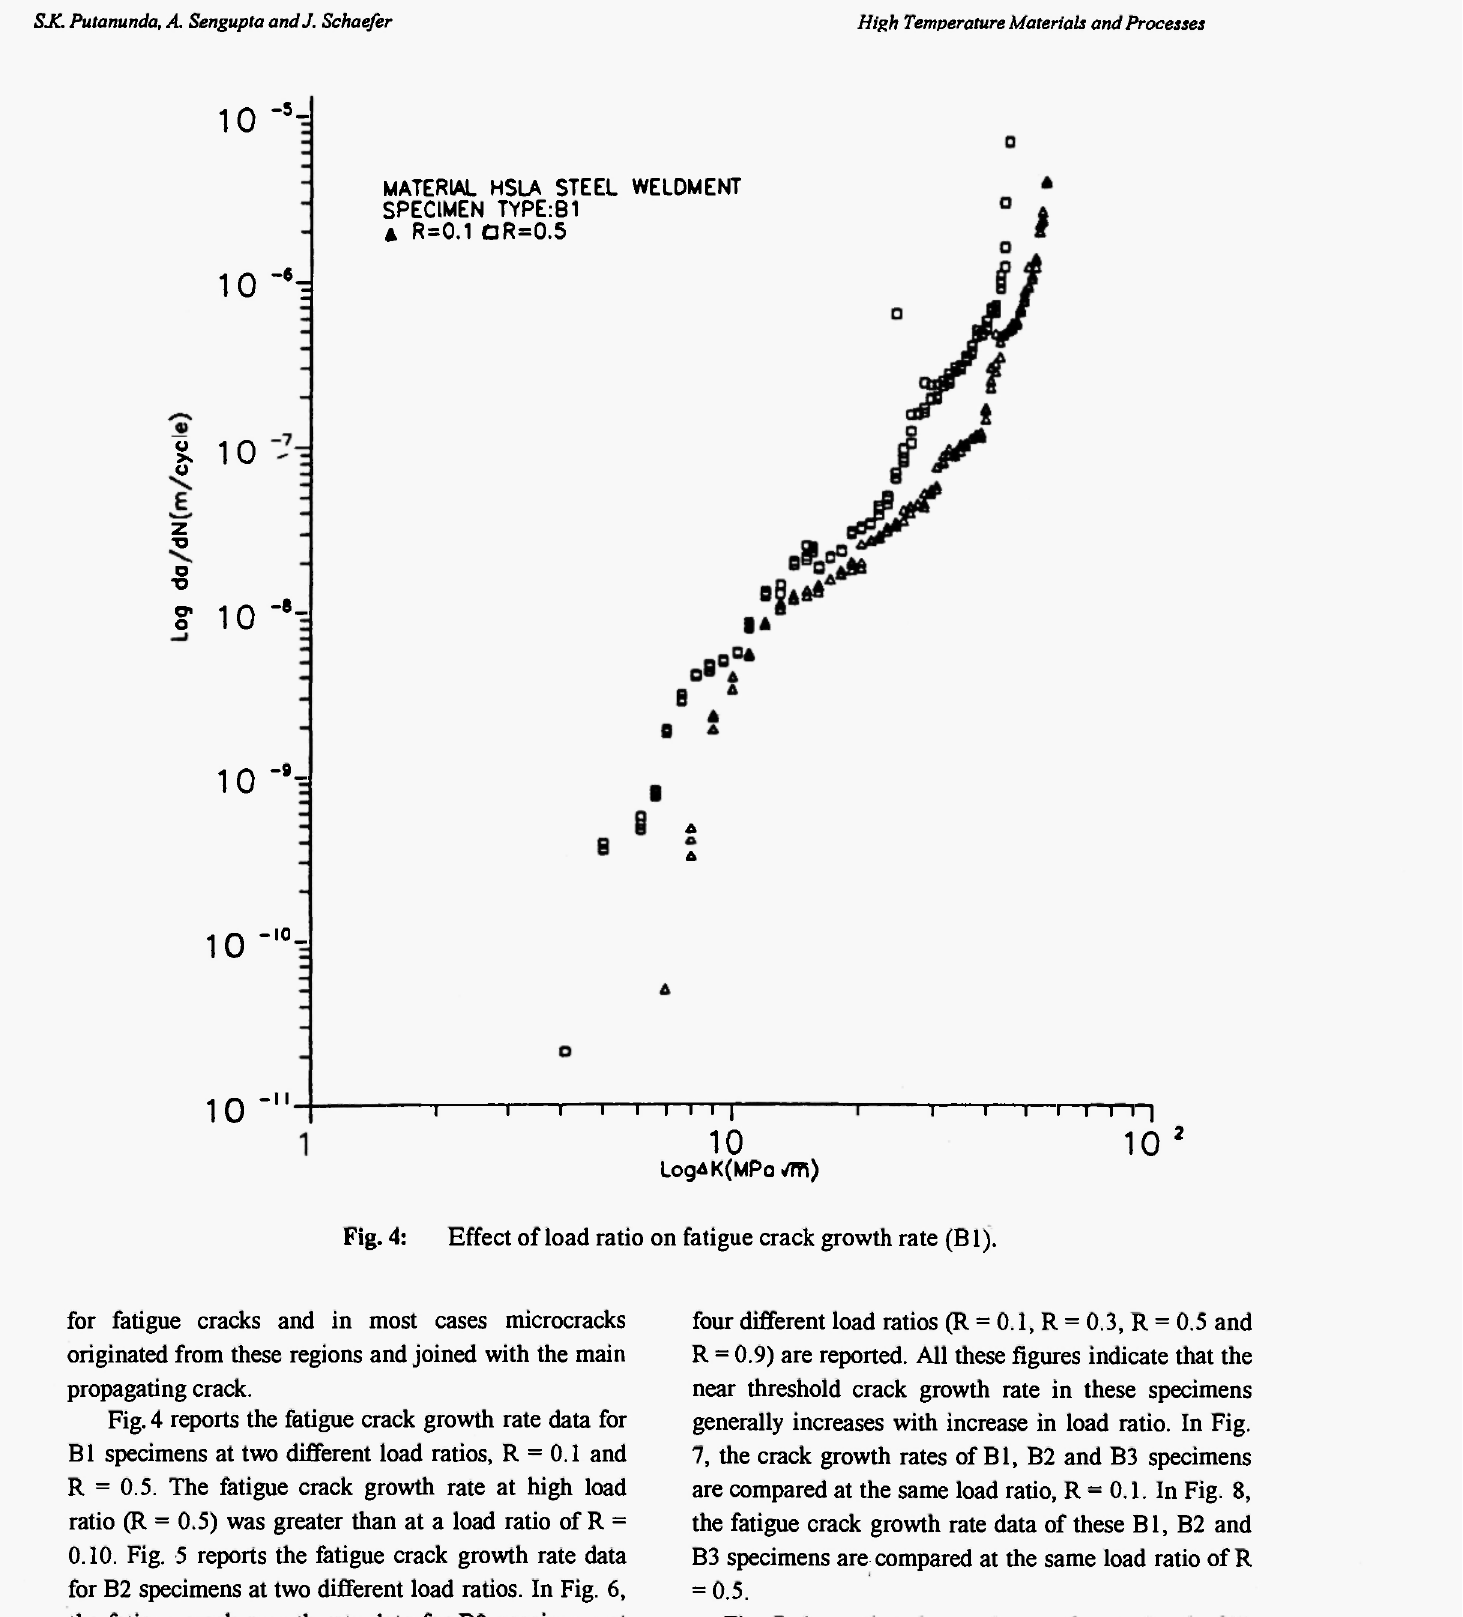
Fig. 4: Effect of load ratio on fatigue crack growth rate